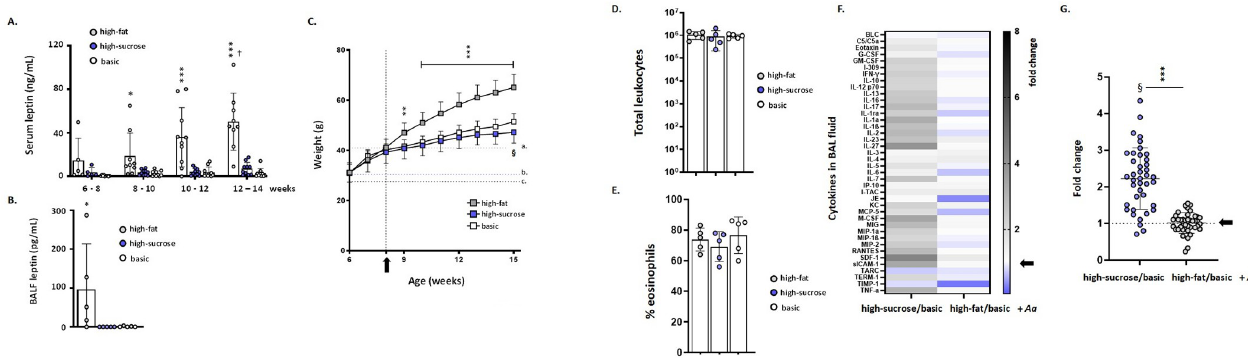
Fig 3. Serum leptin levels have no impact on eosinophil recruitment or cytokine responses in mice maintained on a high-sucrose diet. (A) Serum leptin levels over time in C57BL/6 male mice maintained on basic, high-fat, or high-sucrose diets; n = 5–10 mice per group, � p < 0.05, ��� p < 0.001 for mice on high- fat diet vs . basic or high-sucrose diets, † p < 0.05 for mice maintained on a high-fat diet at weeks 12–14 vs . week 6–8; 2 –way ANOVA with Tukey’s post hoc test; see also S2 Fig. ( B ) Leptin levels in BAL fluid of 16-week-old mice after 10 weeks on each diet (n = 5 mice per group, � p < 0.05 vs . mice maintained on basic or high-sucrose diets, 1-way ANOVA). (C) Weights of male leptin-deficient ob/ob mice on the C57BL/6 background maintained on high-fat, high-sucrose, or basic diets from 8 weeks (at the arrow and vertical dotted line) through 15 weeks of age; n = 10–15 mice per group, �� p < 0.01, ��� p < 0.001, high-fat vs . basic diet, § p < 0.05, basic vs . high-sucrose diet, 2 –way ANOVA with Tukey’s post-hoc test. Dotted horizontal lines a., b., and c. indicate peak weights of wild-type male C57BL/6 mice maintained on high-fat, high-sucrose, and basic diets, respectively as shown in Fig 1A. (D) Total leukocytes and (E) % eosinophils detected in BAL fluid of Aa -challenged ob/ob mice maintained on high-fat, high-sucrose, or basic diets. (F) Heatmap and ( G ) semiquantitative analysis of cytokine profiles detected in BAL fluid of ob/ob mice after repetitive challenge with Aa as shown in Fig 2A. The data shown are ratios of signals detected in BAL fluid from Aa -challenged ob/ob mice maintained on high-fat or high-sucrose diets, with each normalized to signals from BAL fluid from Aa -challenged ob/ob mice maintained on the basic diet and presented fold-increase, n = 5 mice per group as described in the Methods. Arrows indicate no increase over signal detected in mice on basic diet (fold change = 1.0). Mean and SD for all cytokines are as shown in (G) at 2.2 ± 0.84 (high-sucrose/basic) and 1.0 ± 0.28 (high-fat/basic); ��� p < 0.001 (high-sucrose/basic vs . high-fat/basic, Mann-Whitney U-test); § p < 0.001 vs . theoretical mean (= 1.0), one-sample t-tests.